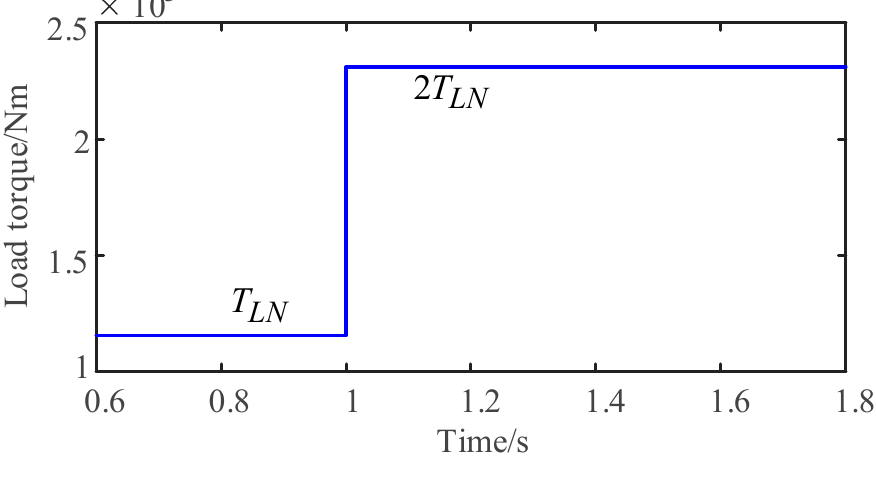
Figure 15. Impact